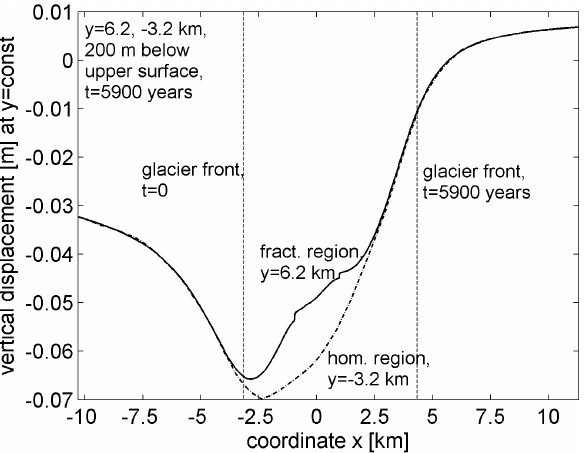
Figure 14. Distribution of the mean effective stress [Pa] within the intact part of the rock mass with fracture zones at time 5900 years. The rock is subjected to spatially non-uniform fluid pressure and compressive stress.